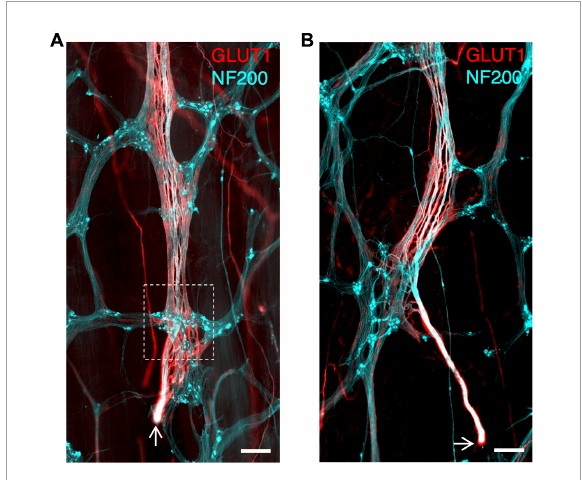
FIGURE3 (A,B) Ascending nerves enter the bowel wall in the rectosigmoid region. Arrows indicate the cut end of the nerve where it was severed during surgery; this cut end lies outside the bowel wall. The myenteric plexus is stained with neurofilament-H (NF200; cyan) as are axons in the ascending nerve. The perineurial sheath of the ascending nerve is labelled with glucose transporter 1 (GLUT1; red). The ascending nerve runs underneath the first myenteric ganglion it encounters (See Supplementary Figure 4 for an animation to visualise the plane of the ascending nerve beneath the ganglion) (white dashed box). All scale bars = 500 µ